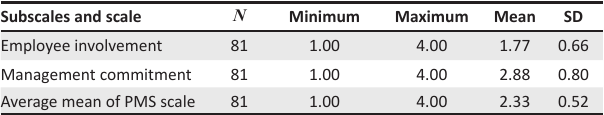
TABLE 3: Means and standard deviations for the two organisational factors and average mean for the performance management system scale. Subscales and scale